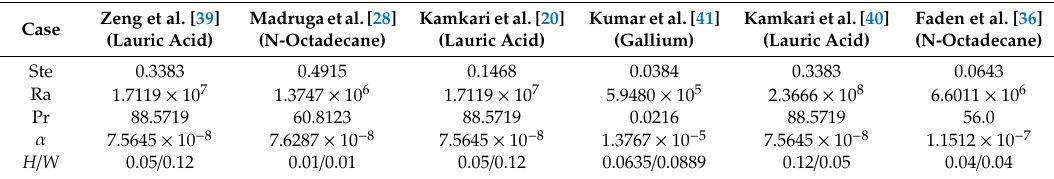
Table 3. The parameters from the references.